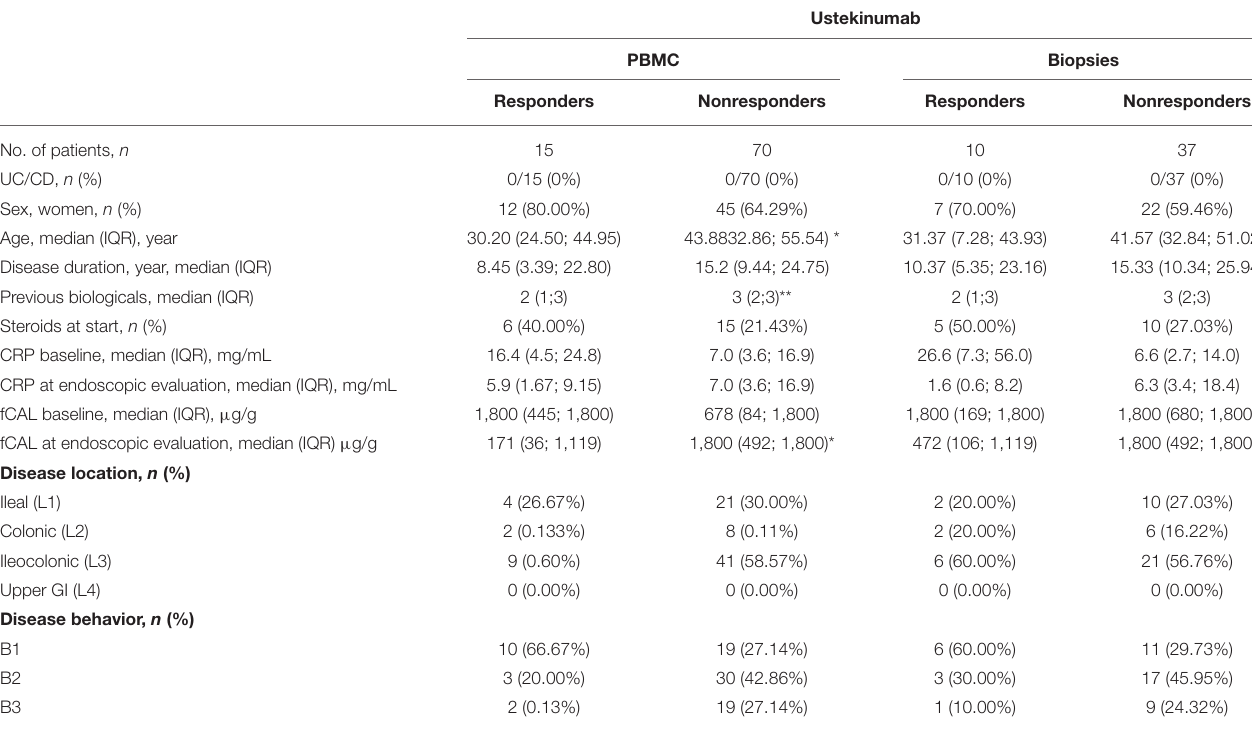
TABLE 2 | Characteristics of patients initiating ustekinumab treatment at baseline (week 0) and endpoint (week